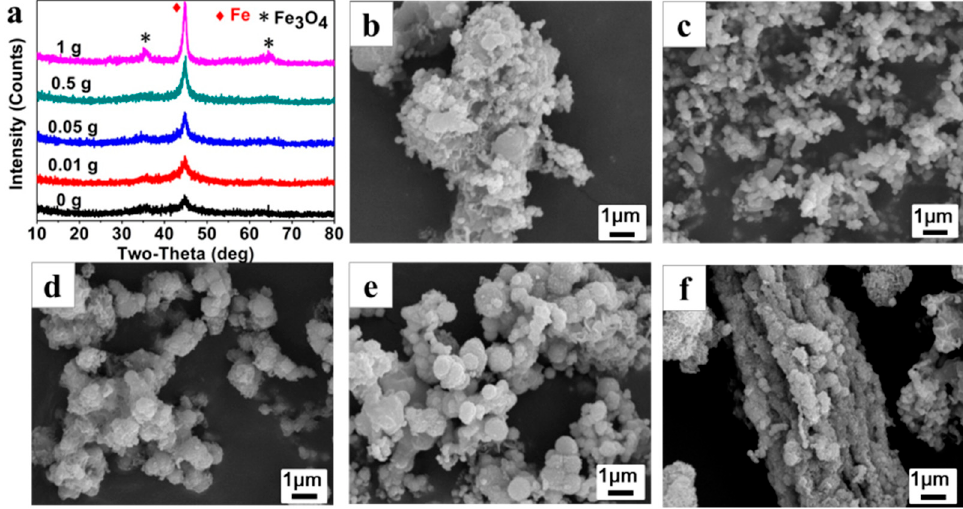
Figure 4. XRD patterns ( a ); SEM photographs ( b – f ) of Fe 0 /Fe 3 O 4 microparticles synthesized under different AMPS additions with a fixed NVP addition of 25 μ L: ( b ) P 025 ; ( c ) P 0.0125 ; ( d ) P 0.0525 ; ( e ) P 0.525 ; and ( f ) P 125 , respectively.